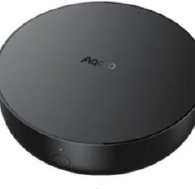
Figure 2. Aqara Home kit.